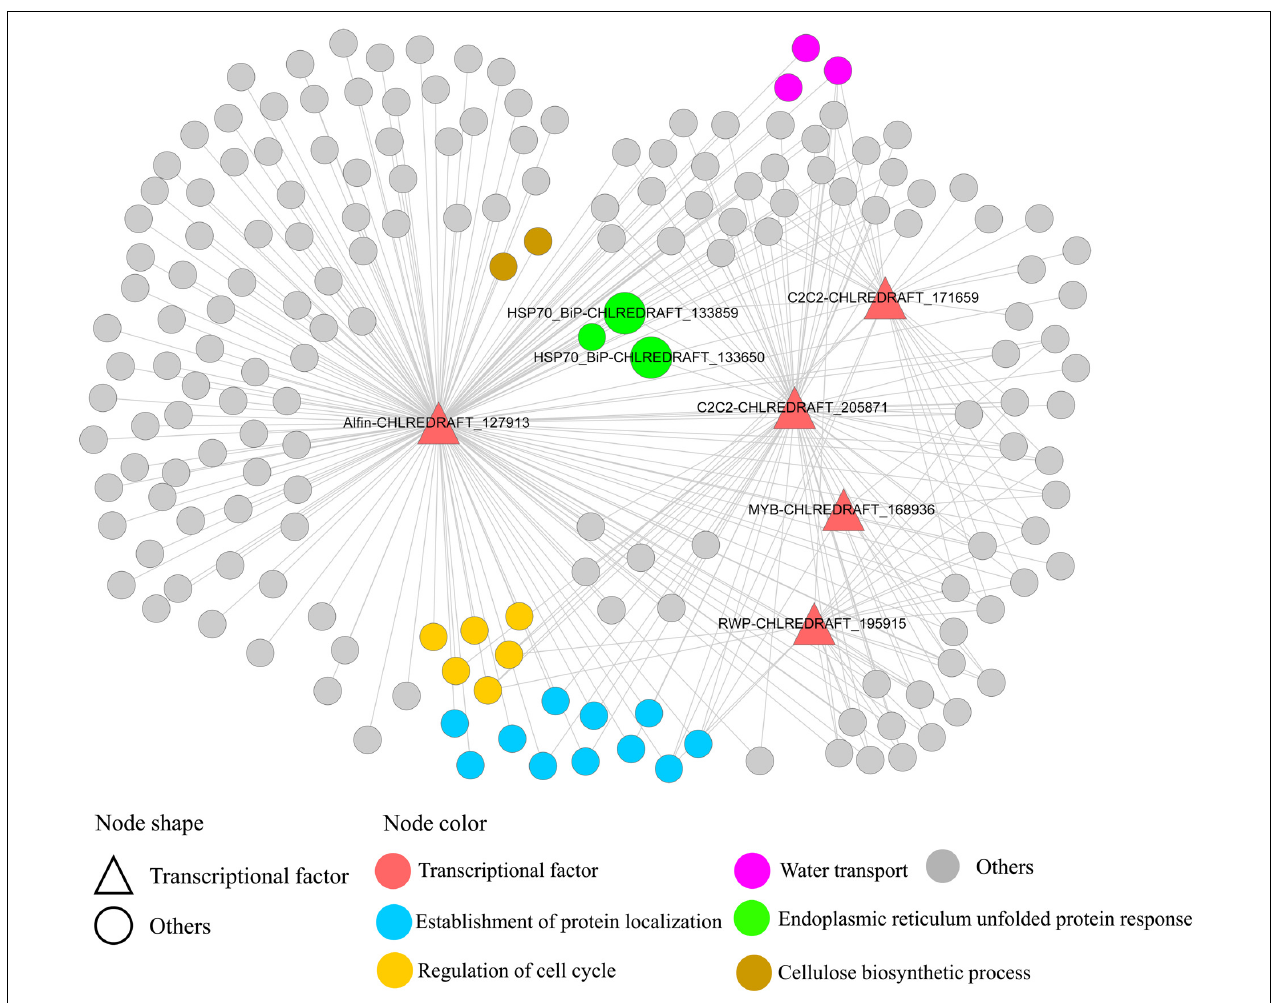
FIGURE 6 | Five TFs regulating genes in co-expression module blue. This module was predicted to regulate endoplasmic reticulum (ER) stress at early time points. TFs (Alfin-CHLREDRAFT_127913, C2C2-CHLREDRAFT_205871, and C2C2-CHLREDRAFT_171659) regulating 11 genes of “establishment of protein localization” and three genes of “endoplasmic reticulum unfolded protein response,” including ER stress key gene BiP (CHLREDRAFT_133650 and